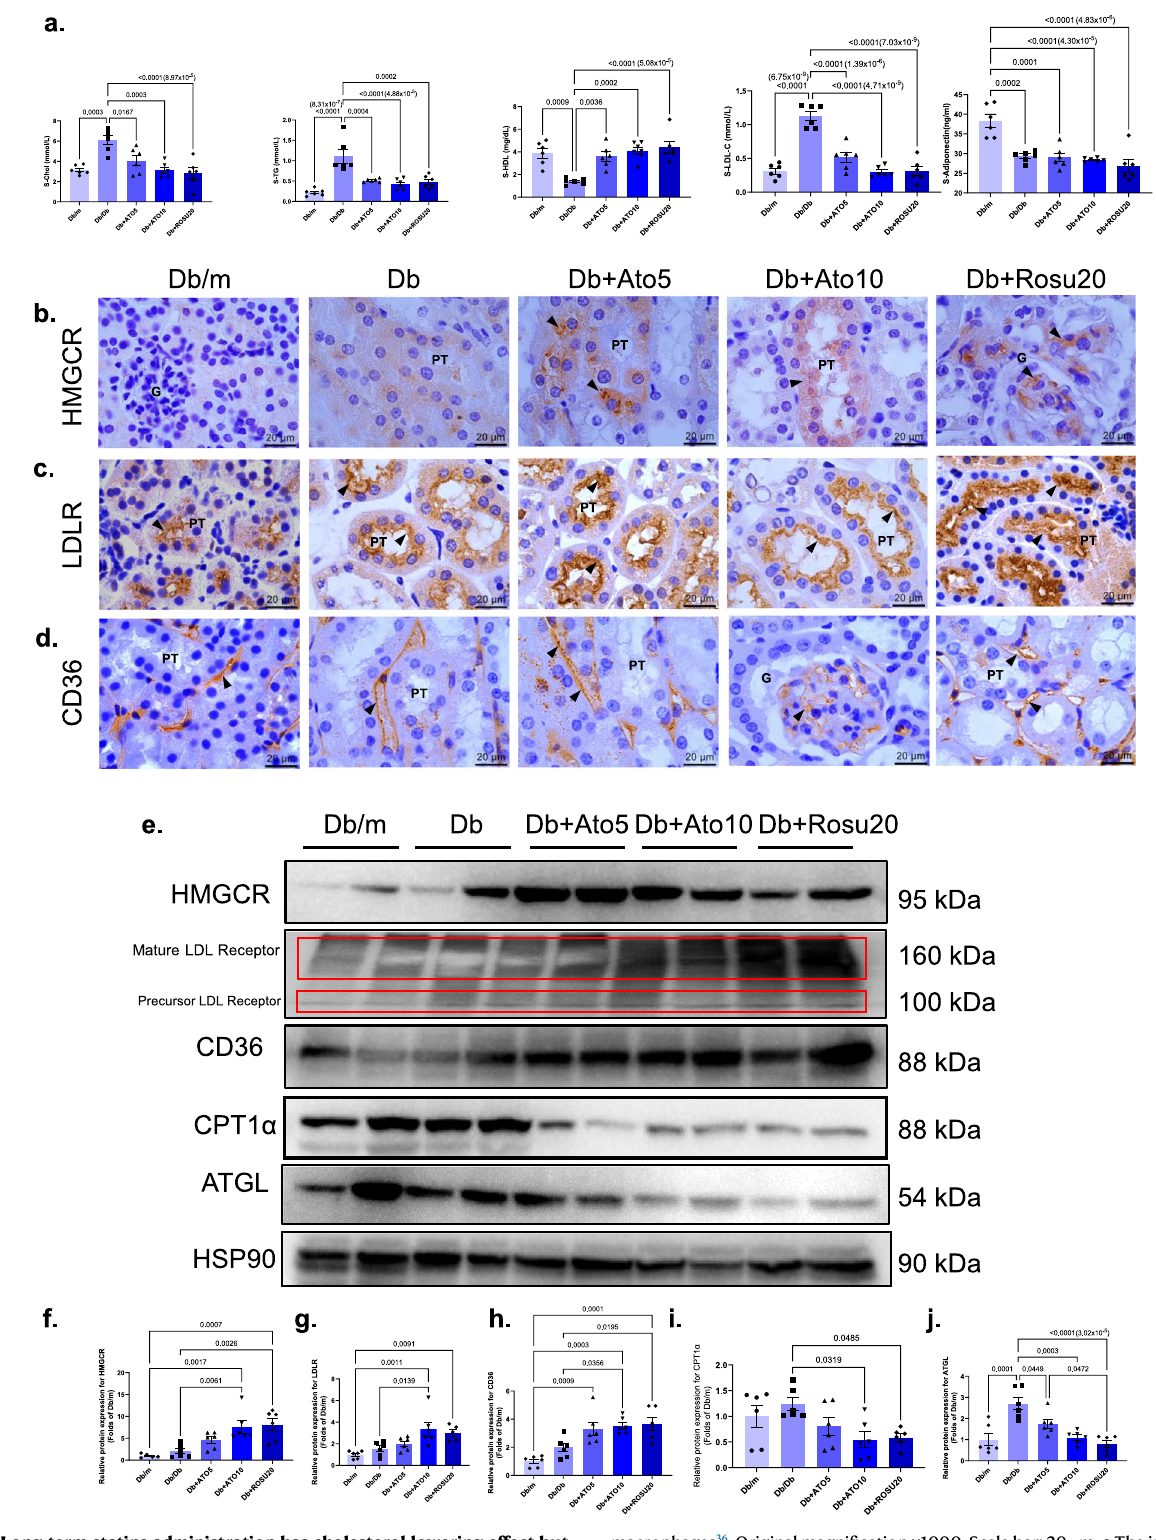
macrophages 36 .Originalmagni fi cation×1000.Scalebar:20 µ m. e Theimmunoblot analysis of HMGCR, LDLR, CD36, CPT-1 α , ATGL, and HSP90. f – j Analysis of the grayscale image between them. All image part of the kidney was cortex. Renal structures indicated as glomerulus (G), proximal tubule (PT), and distal tubule (DT). Data are expressed as means±SEM. n =6 in each group. One-way ANOVA withTukeyposthoctestwasusedfortheanalysisofstatisticalsigni fi cance.Source data are provided as a Source Data fi